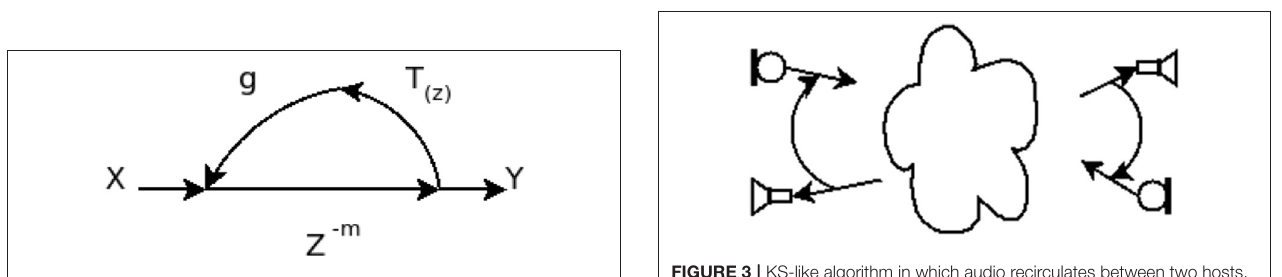
FIGURE 1 | A filtered delay loop (FDL) which is an infinite impulse response (IIR) “unit reverberator.” The output signal Y is the result of mixing the input signal X with feedback from T( z ) which has been delayed by m samples and multiplied by gain g .